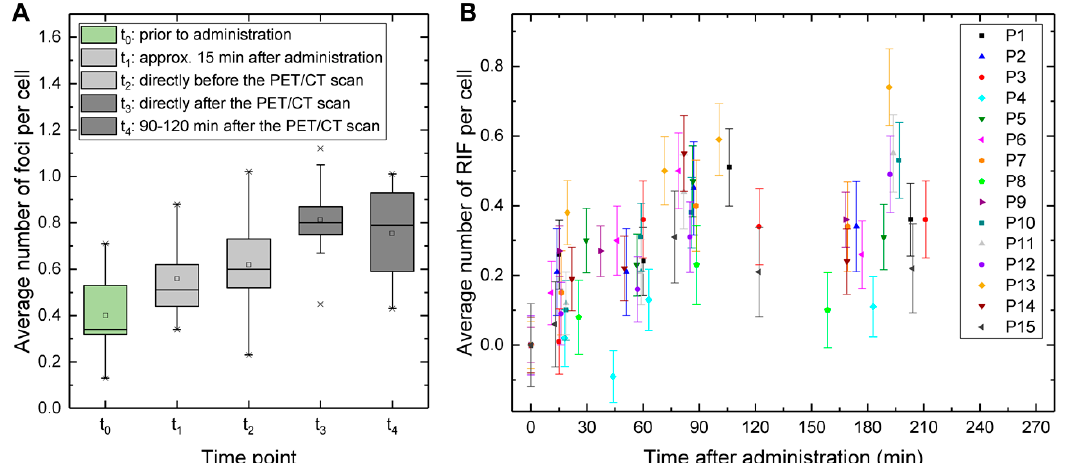
Figure 2. In vivo study—time-dependency of the average number of foci and radiation induced foci (RIF). ( A ) Boxplot of the average number of foci per cell at the five sampling time points t 0 to t 4 . The mean of the average number of foci at the time points t 1 , t 2 , t 3 , and t 4 is significantly elevated compared to the mean baseline value at t 0 . A significant increase of the average number of foci was also observed from t 1 to t 2 and from t 2 and t 3 . ( B ) Patient-specific average number of RIF per cell as a function of the time after administration.